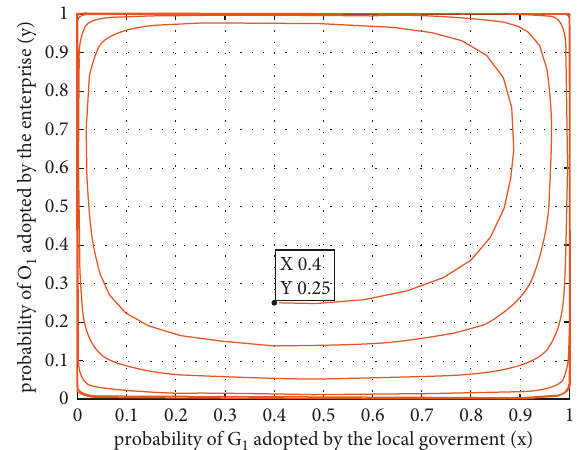
Figure 6: Dynamic evolutionary paths of local government and enterprise for system 2.